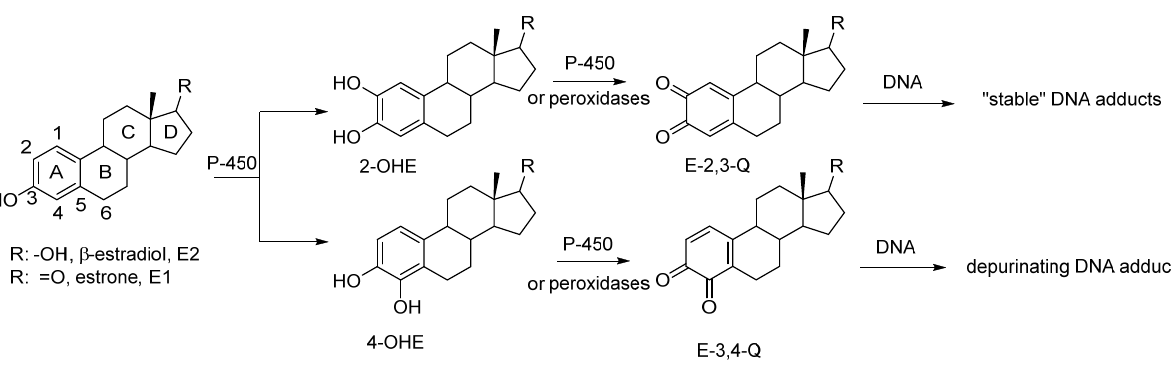
Figure 1. Oxidative metabolism of estrogen to catechol estrogens and estrogen o -quinones and subsequent reaction with